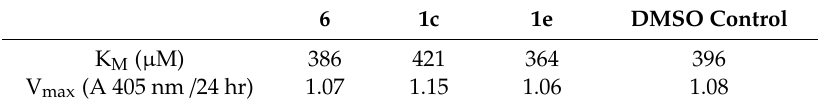
Table 3. Calculated SAP K M and V max (from Lineweaver-Burk Plots) after 24-h incubation.